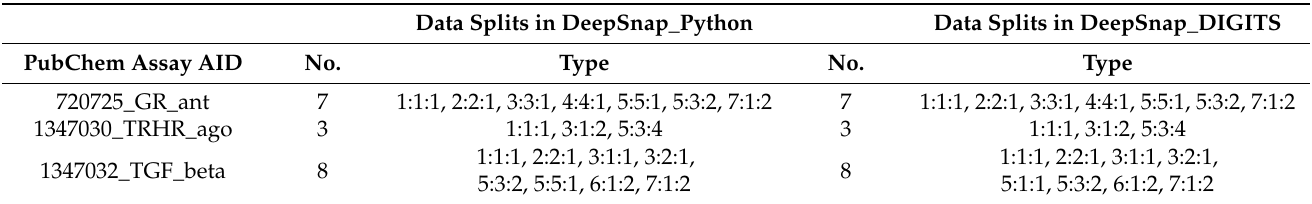
Table 2. Data splits used in DeepSnap on modeling of the three MIE